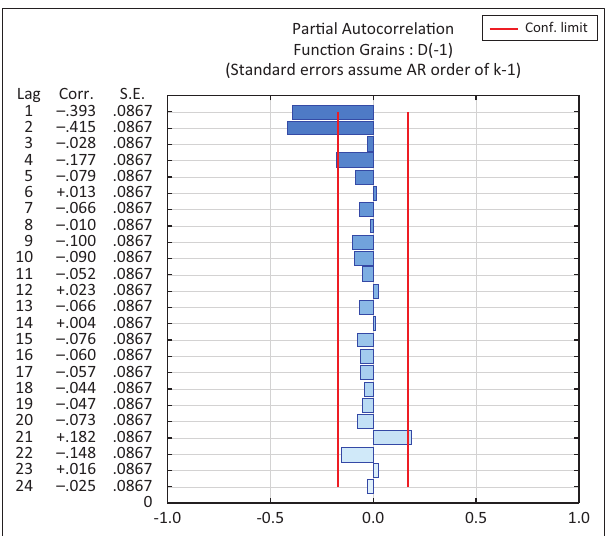
FIGURE 5: Partial autocorrelation for